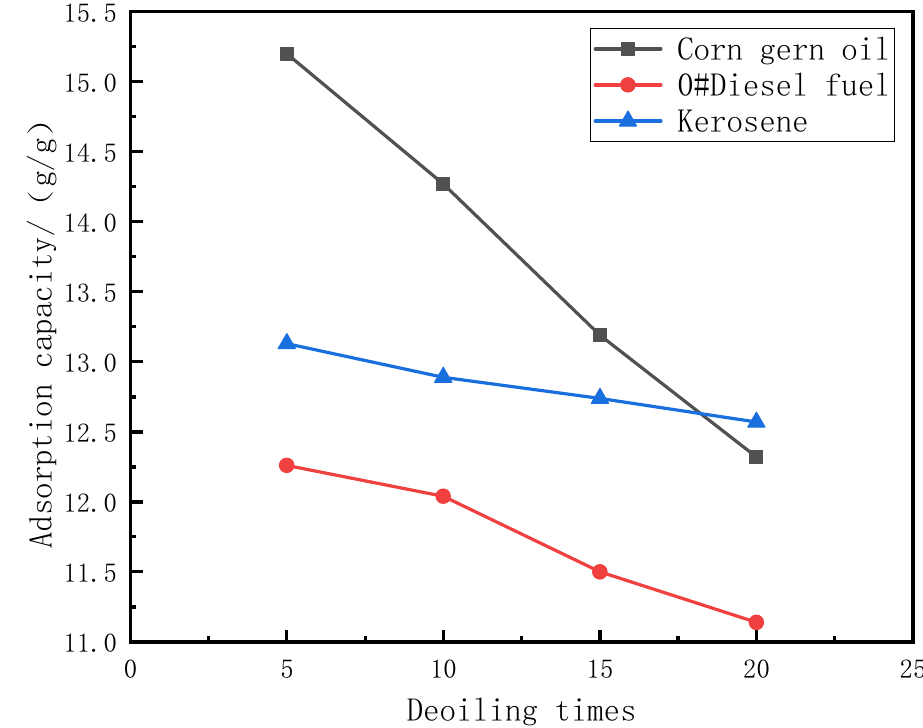
Figure 9. Adsorption capacity of PDMS@Fe 3 O 4 /MS after multiple cycles.